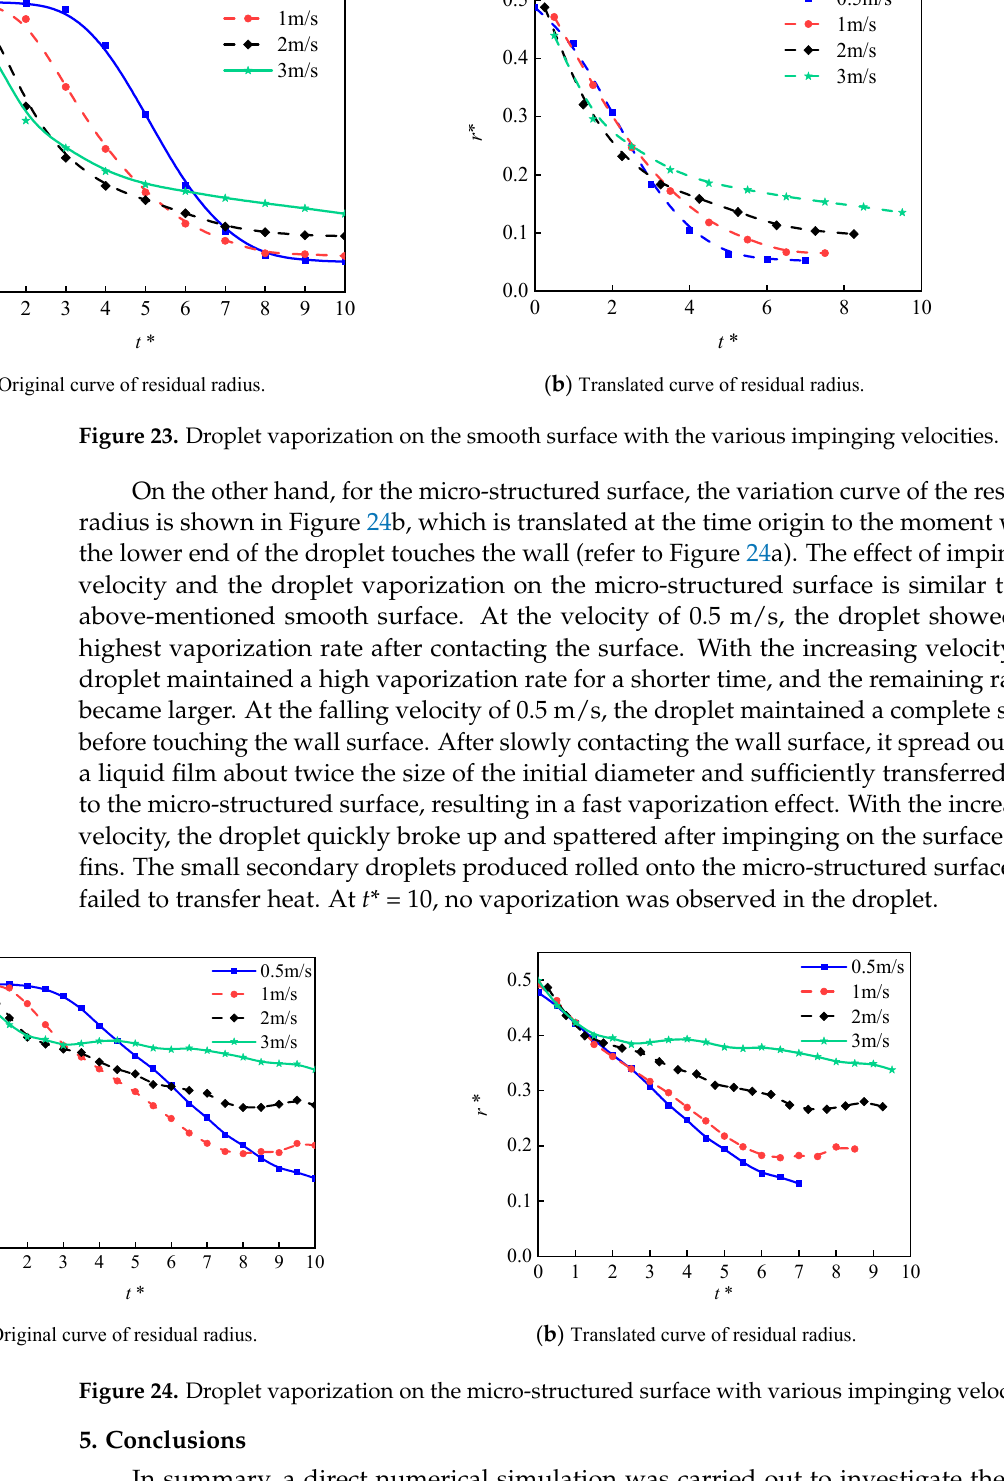
Figure 24. Droplet vaporization on the micro-structured surface with various impinging velocities.